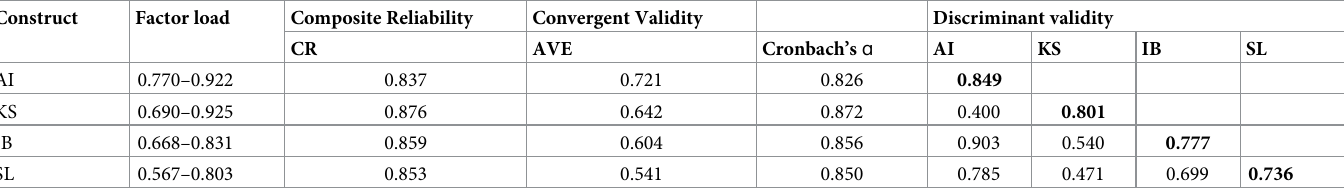
Table 3. Reliability, convergent validity, and discriminant validity.